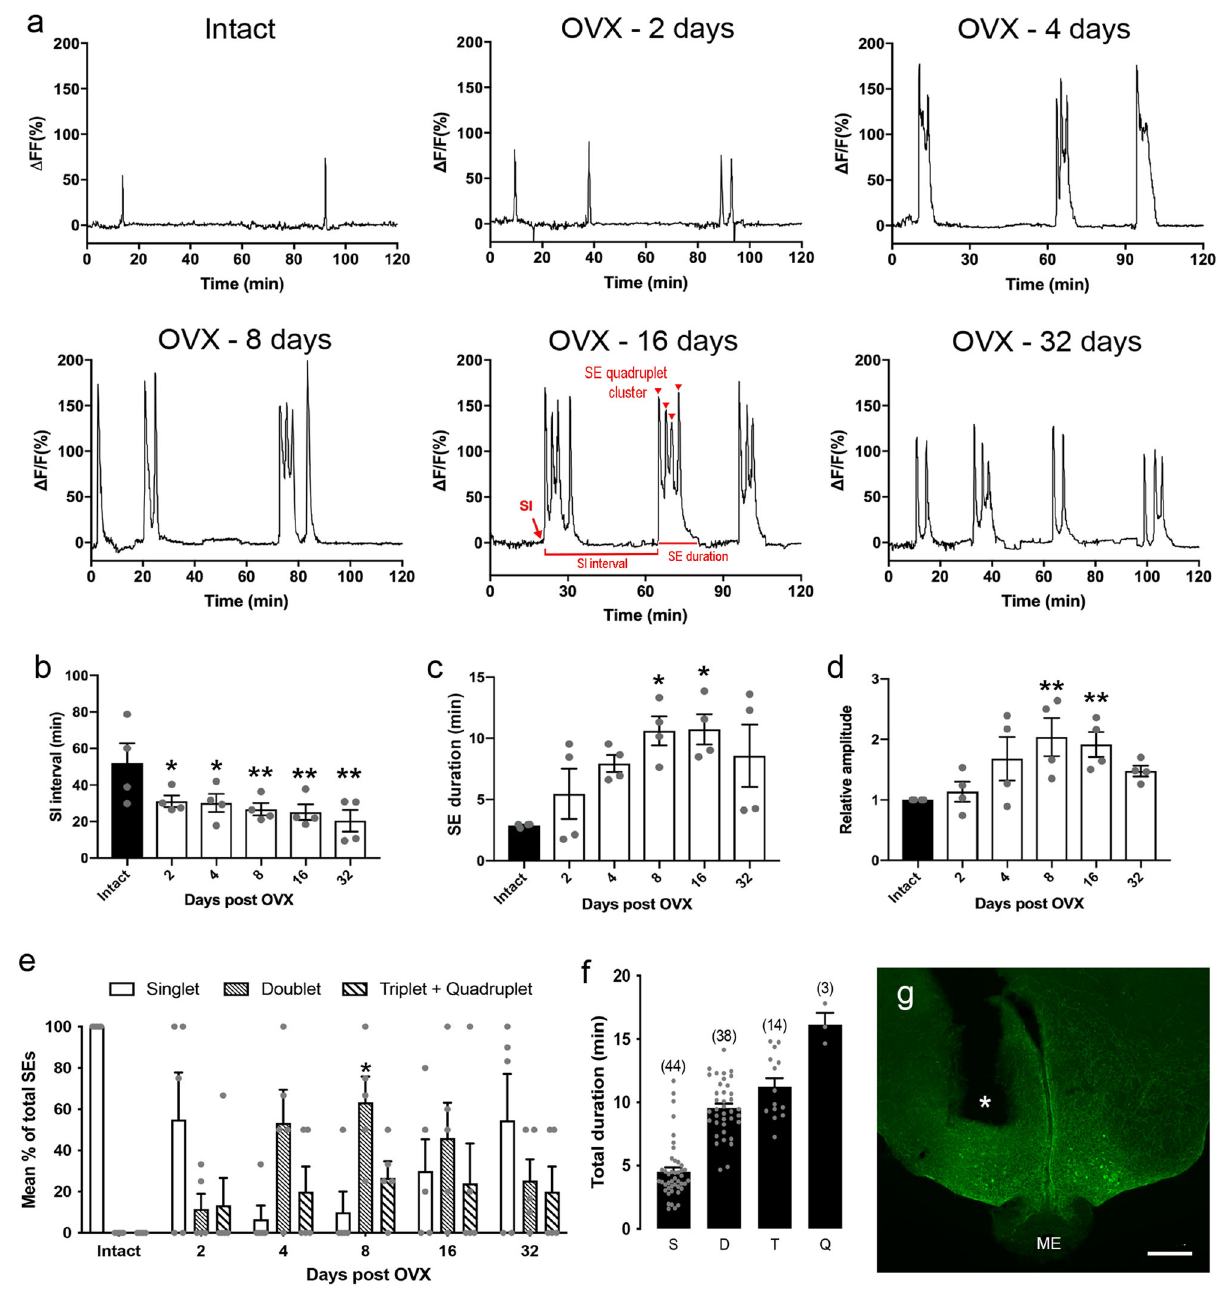
Fig. 1 | Changes in GnRH pulse generator activity with time following ovar- iectomy (OVX). a Representative example of GCaMP6 photometry recordings fromARN KISS neuronsofasinglemousebeforeand2,4,8,16,and32daysfollowing ovariectomy. Red text on 16 day pro fi le illustrates the parameters measured; the synchronization initiation (SI), duration and interval and the individual synchro- nization events (SEs) occurring within clusters (red arrowheads). b Graph showing the mean±SEM and individual data points for the inter-SI interval before (Intact) and following OVX (RM one-way ANOVA; P =0.006; N =4) * and ** signi fi cantly different from the intact group, Dunnett ’ s multiple comparisons ( P <0.05